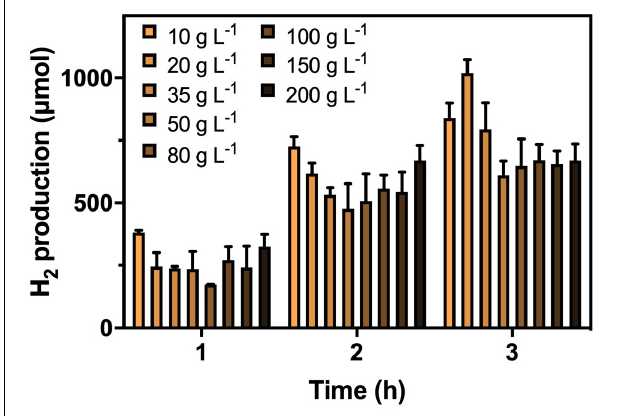
FIGURE 2 | H 2 production by K. pneumoniae under different CG concentrations after optimized cultivation and hydrogenase induction in 3